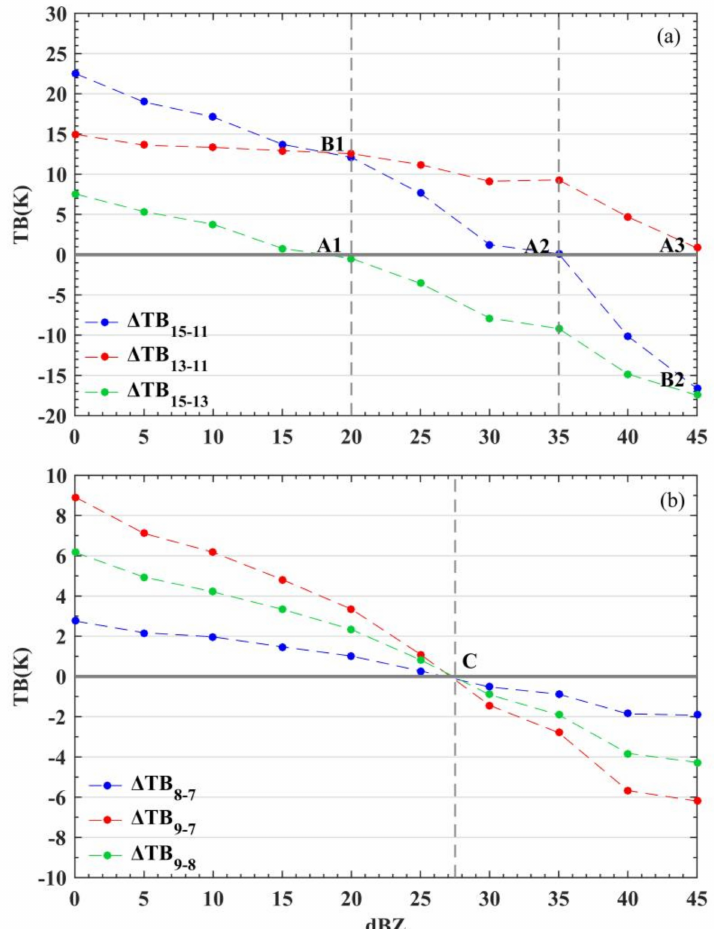
Figure 5. Brightness temperature di ff erences versus radar reflectivity for the three humidity-sounding channels 11, 13, and 15 ( a ), and three temperature-sounding channels 7, 8, and 9 ( b ), with data sampled from July to September in 2016. The four points A1 (20 dBZ, 0K), A2 (35 dBZ, 0K), A3 (45 dBZ, 0K), and C (27.5 dBZ, 0K) indicate that ∆ TB 15-13 , ∆ TB 15-11 , ∆ TB 13-11 , ∆ TB 8-7 , ∆ TB 9-7 , and ∆ TB 9-8 reach 0 K, respectively. Additionally, the order relation of ∆ TB 15-11 and ∆ TB 13-11 as well as ∆ TB 15-11 and ∆ TB 15-13 reverses from points B1 and B2,